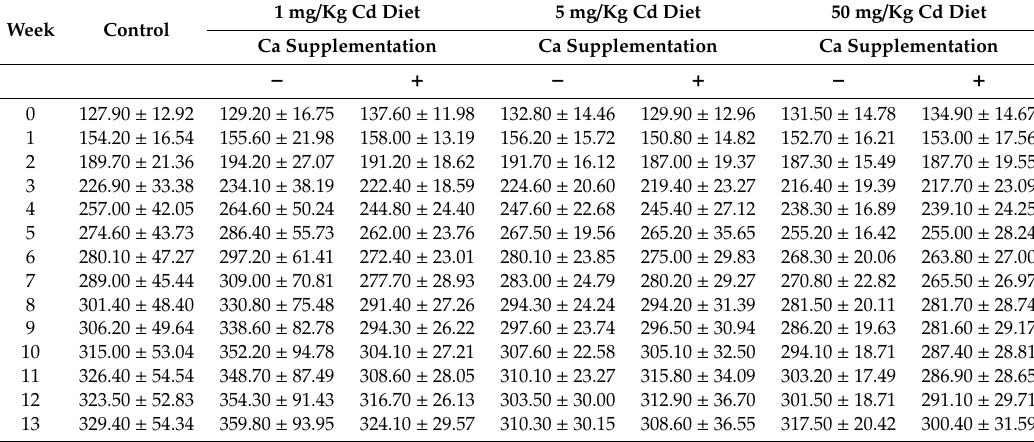
Table 7. Body weight of female rats in the study of moderate Ca supplementation exposure to di ff erent diet Cd (Exp 2).